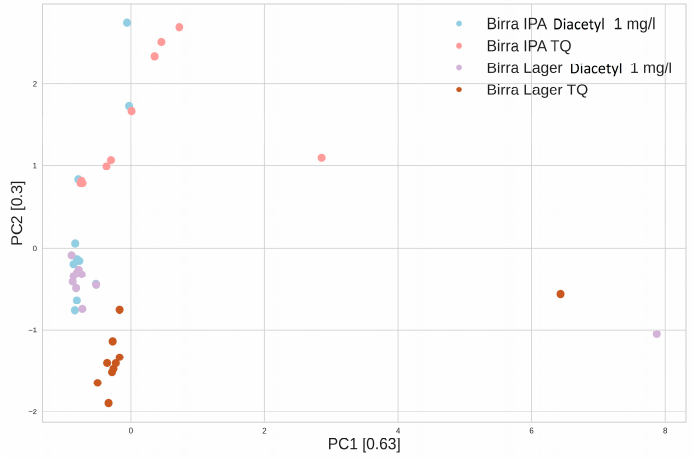
Figure 7. PCA between IPA and lager beers, unaltered and with 1 mg/L of diacetyl. Pink dots: IPA (US); brown dots: lager (US); light blue dots: IPA with 1 mg/L of diacetyl; purple dots: lager with 1 mg/L of diacetyl.